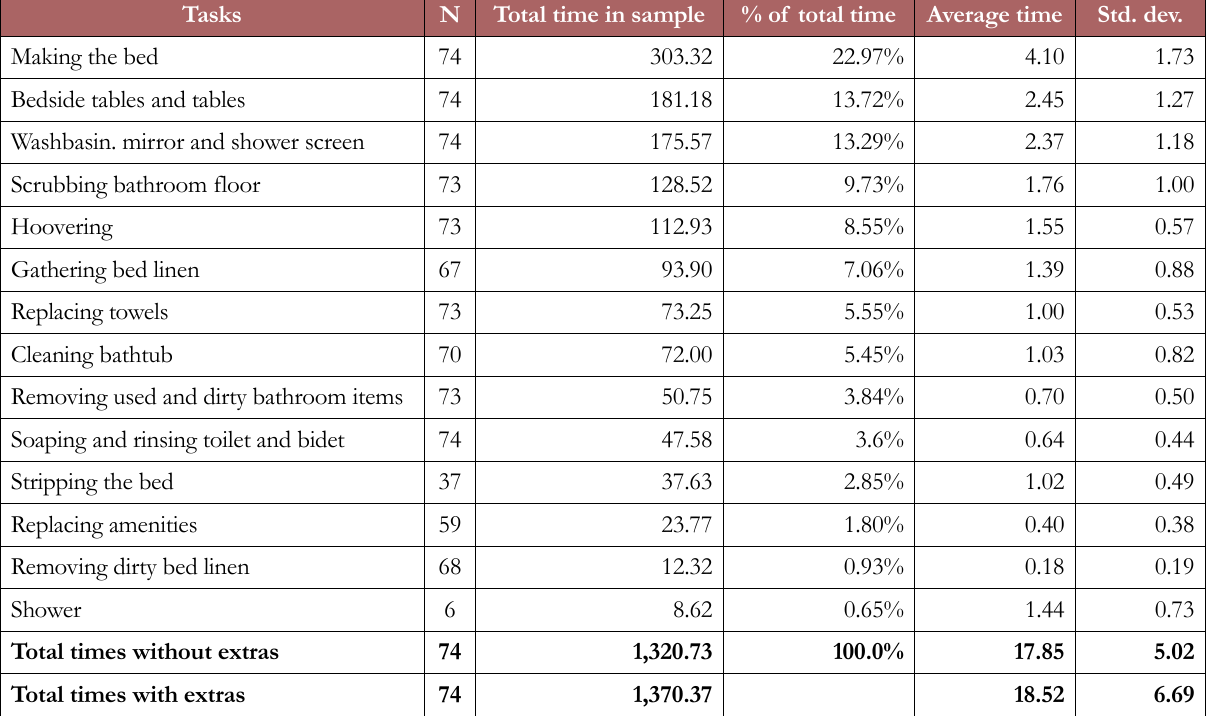
Table 4. Descriptive statistics of room cleaning times (in